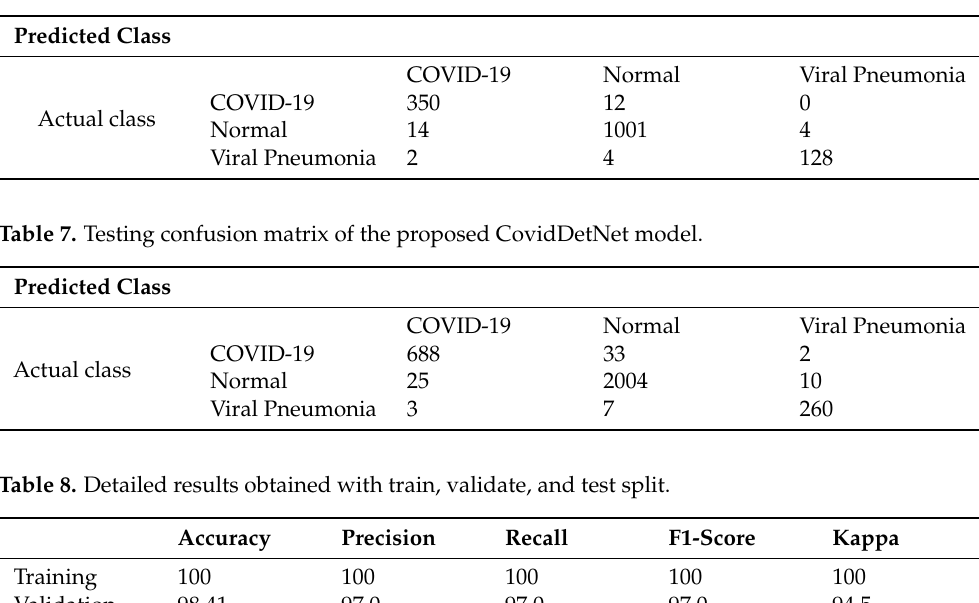
Table 6. Validation confusion matrix of the proposed CovidDetNet model.